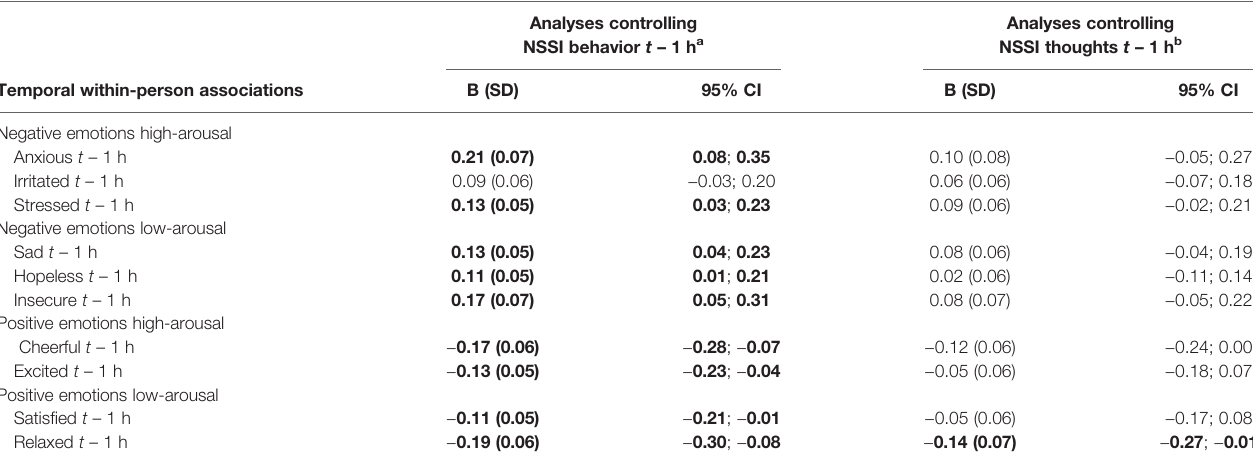
TABLE 6 | Temporal within-person associations between speci fi c emotions and non-suicidal